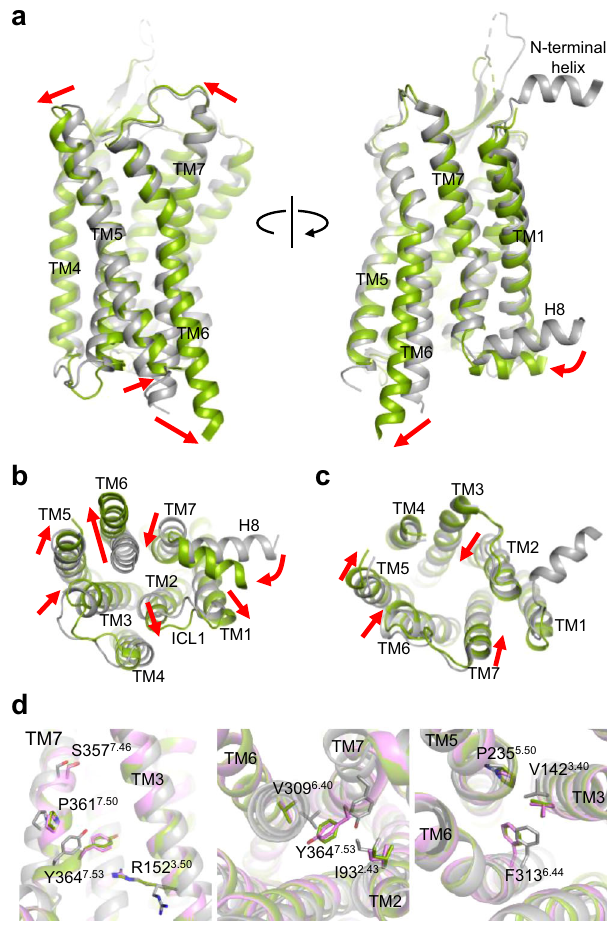
Fig. 2 Comparison of inactive-state and active-state OX 2 R. a Superposition of OxB-activated (green) and inactive-state OX 2 R (gray; PDB ID 5WQC) viewed from two different angles from within the membrane. Red arrows indicate conformational transitions upon OX 2 R activation. b , c Intracellular and extracellular view of the superimposed receptor structures, respectively. Residues 192 – 214 of ECL2 have been removed for clarity. d Arrangement of conserved motifs associated with receptor activation: DRY (left), NPxxY (middle), and hydrophobic core triad (right). Structures with OxB (green) and compound 1 (purple) are overlaid with inactive-state OX 2 R